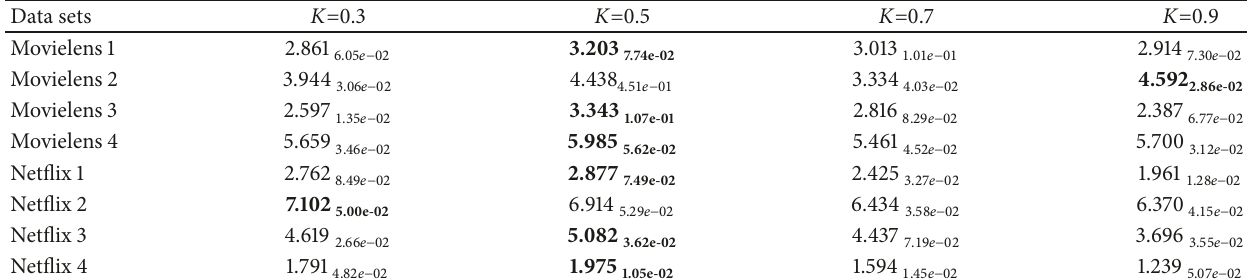
Table 7: HV comparison results under different settings of K to MOEA-EPG on the accuracy-coverage space. Data